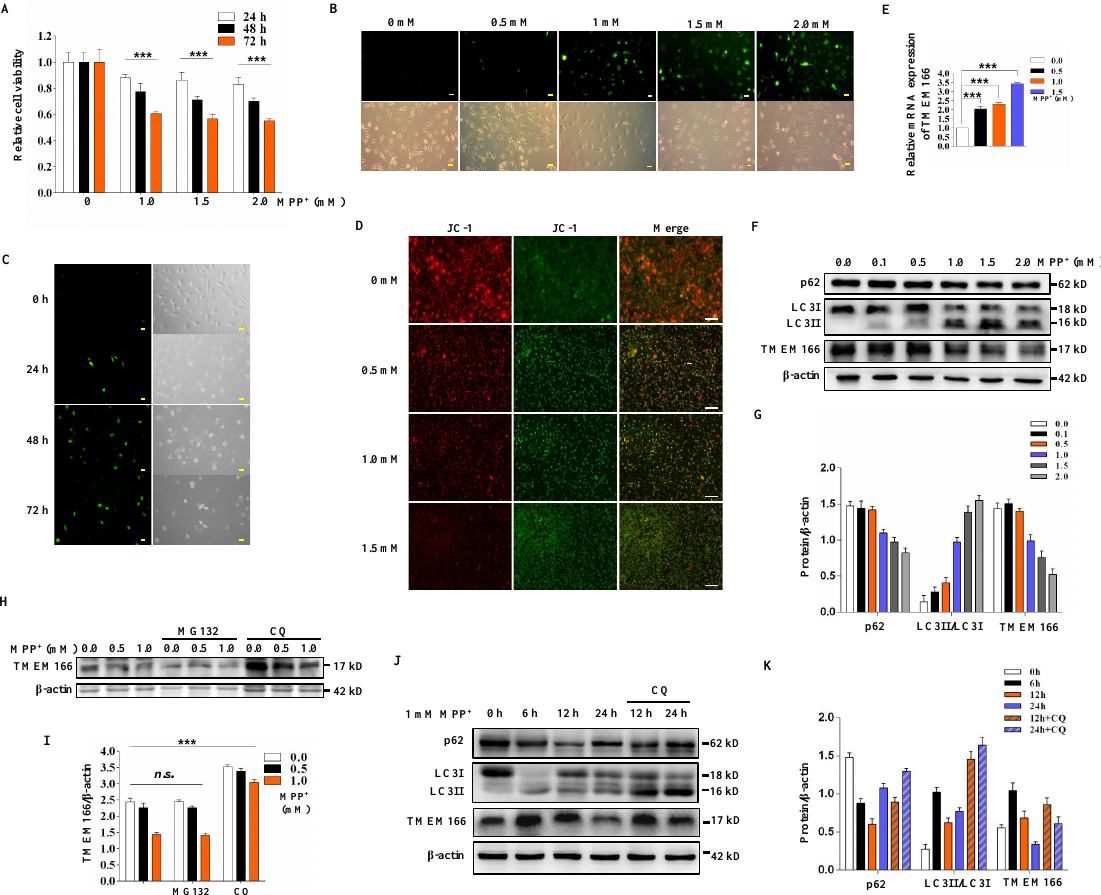
Figure 1. TMEM166 is degraded by autophagy under MPP + -induced oxidative stress. ( A ) Relative viability of SH-SY5Y cells after treatment with different concentrations of MPP + for the indicated times. *** p < 0.001 vs. 0 mM (n = 4; means ± SDs). ( B ) SH-SY5Y cells were treated with MPP + at the indicated concentrations for 24 h and then intracellular reactive oxygen species (ROS) were detected by DCFH-DA staining and visualized by fluorescence microscopy. Scale bars, 50 µ m. ( C ) SH-SY5Y cells were treated with 1 mM MPP + for the indicated time and then intracellular ROS were detected. Scale bars, 50 µ m. ( D ) SH-SY5Y cells were treated with MPP + at the indicated concentrations for 24 h and then the mitochondrial membrane potential was detected by JC-1 staining and visualized by fluorescence microscopy. Scale bars, 500 µ m. ( E , F ) SH-SY5Y cells exposed to MPP + at the indicated concentrations for 24 h were assessed for TMEM166 mRNA levels by qRT–PCR and its protein levels by Western blot. Relative mRNA expression levels were normalized to the 0.0 mM control. *** p < 0.001 vs. 0.0 mM (n = 3; means ± SDs). β -actin was used as a loading control. ( G ) Qualification analysis of blot bands of protein from ( F ) with ImageJ v1.53k. ( H ) SH-SY5Y cells were exposed to MPP + at the indicated concentrations for 24 h with or without MG132 (3 µ M) or CQ (20 µ M) and TMEM166 levels were determined by Western blot. ( I ) Qualification analysis of blot bands of TMEM166 from ( H ). *** p < 0.001, n.s. p ≥ 0.05 (n = 3; means ± SDs). ( J ) SH-SY5Y cells were treated with 1 mM MPP + for the indicated time in the presence or absence of CQ (50 µ M, last 1.5 h) and protein levels were determined by Western blot. ( K ) Qualification analysis of blot bands of protein from ( J